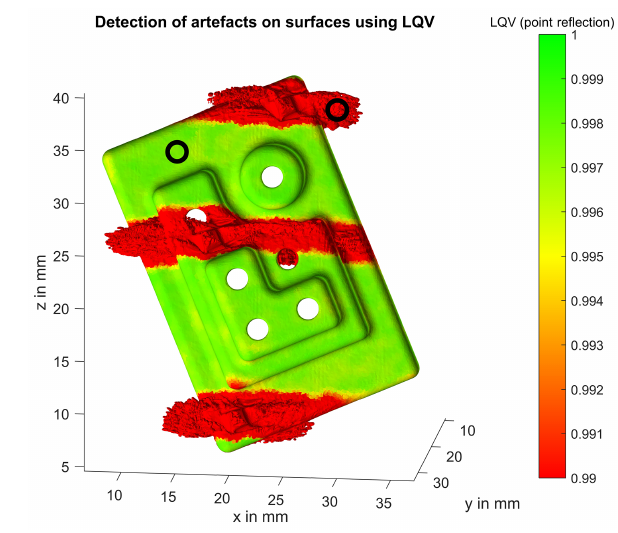
Figure 2. Detection of locally occurring artefacts provoked by wol- fram insertions with the LQV method (point reflection). The surface regions belonging to the transitions depicted in Fig. 1 are marked with black